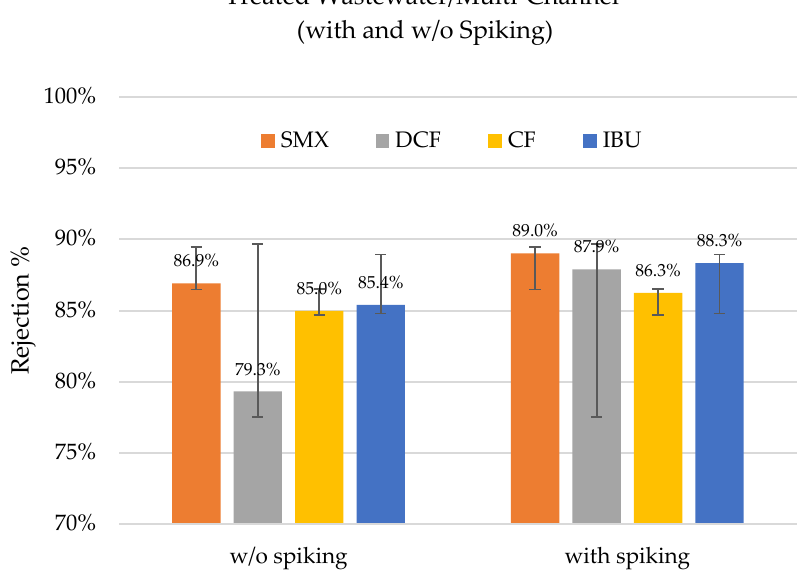
Figure 5. Rejection percentages of sulfamethoxazole (SMX), diclofenac (DCF), clofibric acid (CF), and ibuprofen (IBU) with spiking and without spiking in the treated wastewater with a multi-channel hybrid membrane at a TMP of 4 bar (n = 2). Table 5. Measured concentrations in the experiments with and without spiking (n = 2).